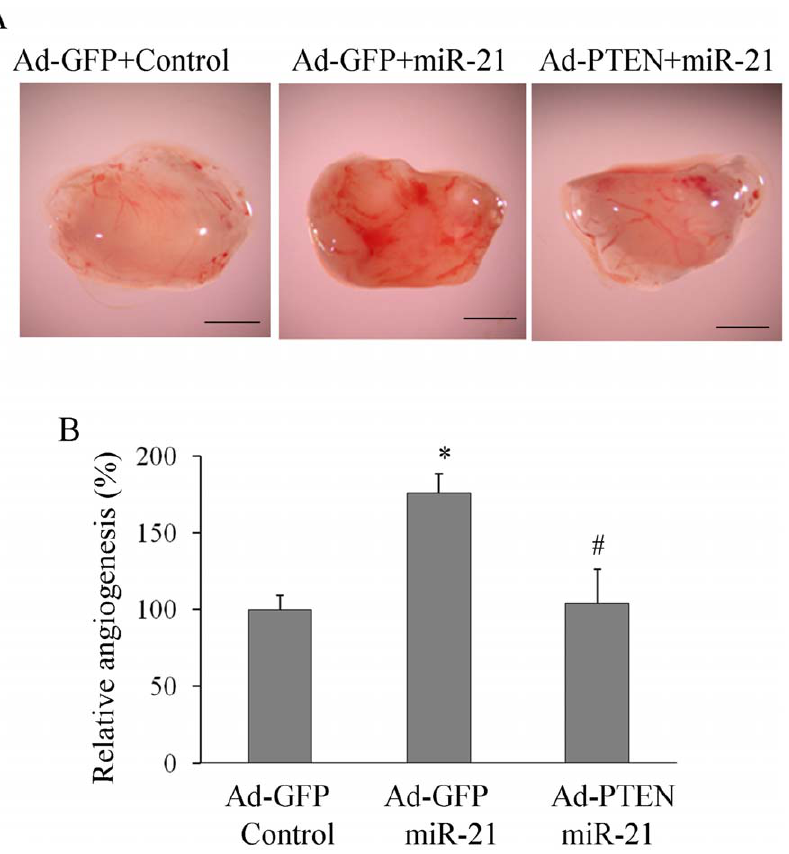
Figure 3. PTEN was the downstream target of miR-21 in inducing angiogenesis. (A) DU145 cells were infected with adenovirus carrying GFP (Ad-GFP) or PTEN (Ad-PTEN). After 24 h, cells were transfected with pre-miR-21 or scrambled control. The next day, cells were trypsinized and angiogenesis assay was performed as above. The representative plugs from treatments of Ad-GFP plus scrambled control, Ad-GFP plus pre-miR-21, and Ad-PTEN plus pre-miR-21 were shown in the picture. Scale , 2 mm. (B) The relative angiogenesis was showed in the bar graph. Results from each group are presented as mean 6 SD of 6 samples. * indicates the significant increase when compared to the Ad-GFP plus scrambled control group ( p , 0.05). # , indicates the significant decrease when compared to Ad-GFP plus miR-21 group ( p , 0.05).